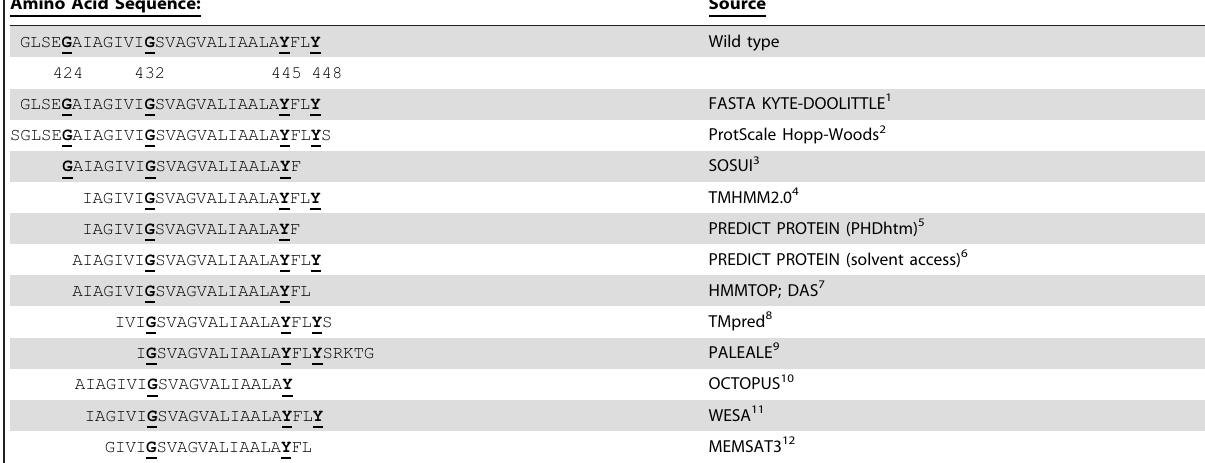
Table 1. Survey of Servers.